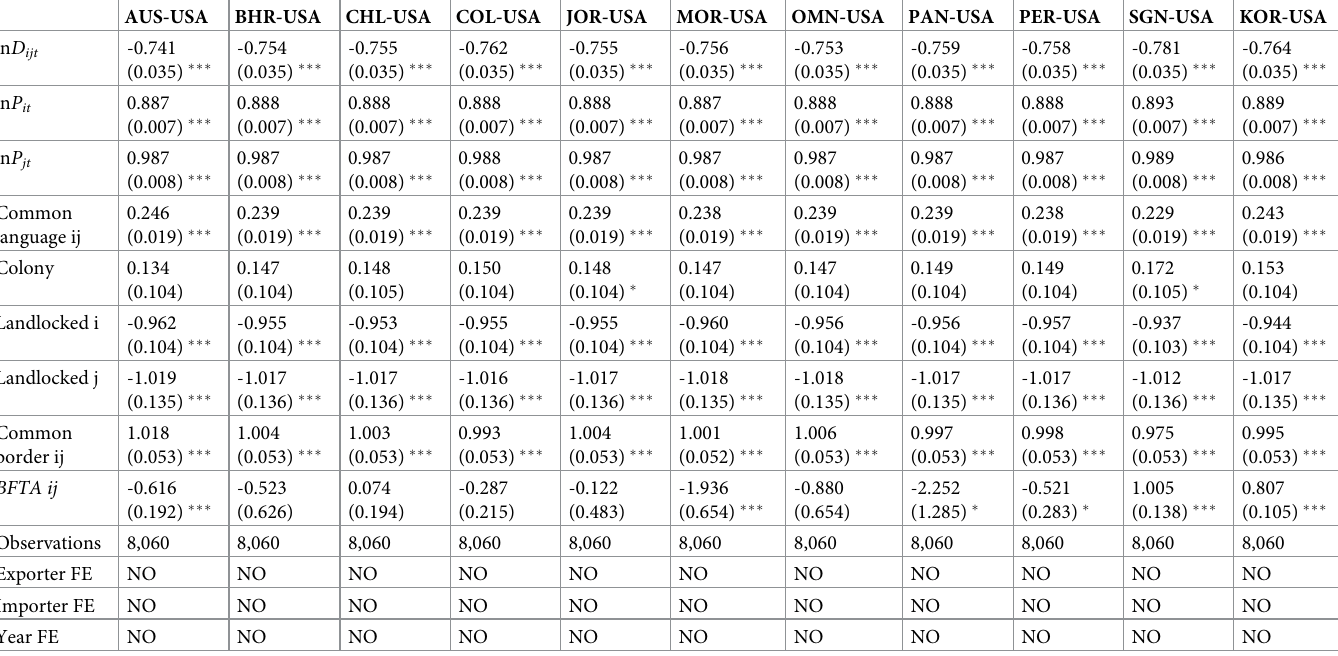
Table 8. PPML estimation results without fixed effects for the United States as an